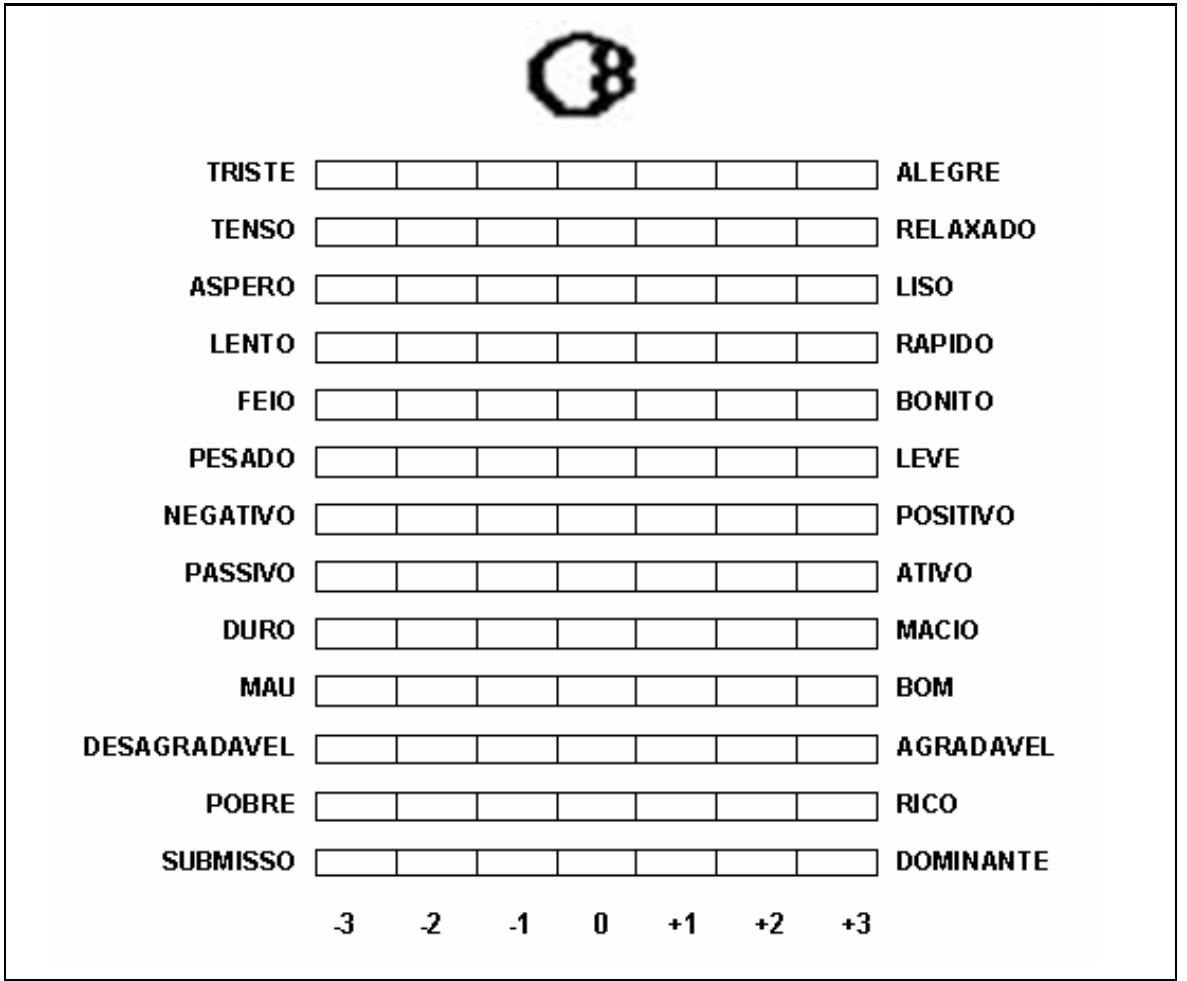
Figura 3 . Exemplo de estímulo abstrato e escalas utilizadas pelos participantes nas avaliações